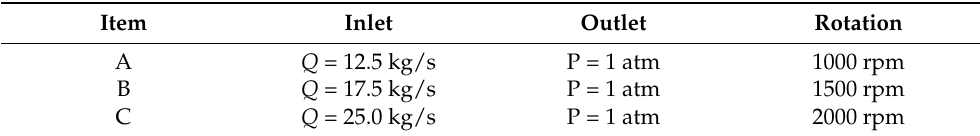
Table 2. Boundary conditions of A, B, and C